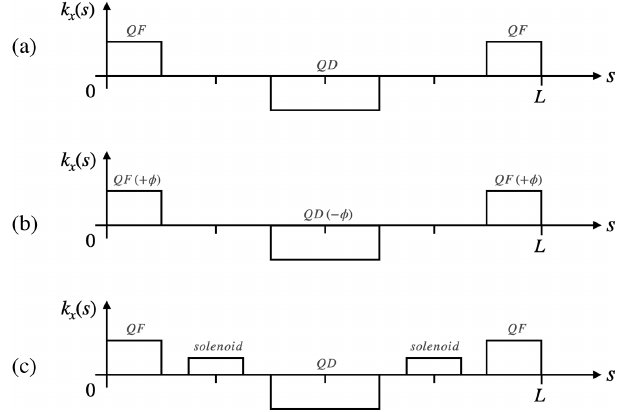
plots.FIG. 7. The horizontal focusing strength as a function of s in a FODO lattice with period length L . The quadrupoles have length L= 4 and are equally spaced. (a) The quadrupoles are upright and the phase advance is 80° in both planes. (b) The quadrupoles are rotated by ϕ ¼ 3 ° in the transverse plane ( QF and QD are rotated in opposite directions). (c) Solenoid magnets are inserted between the